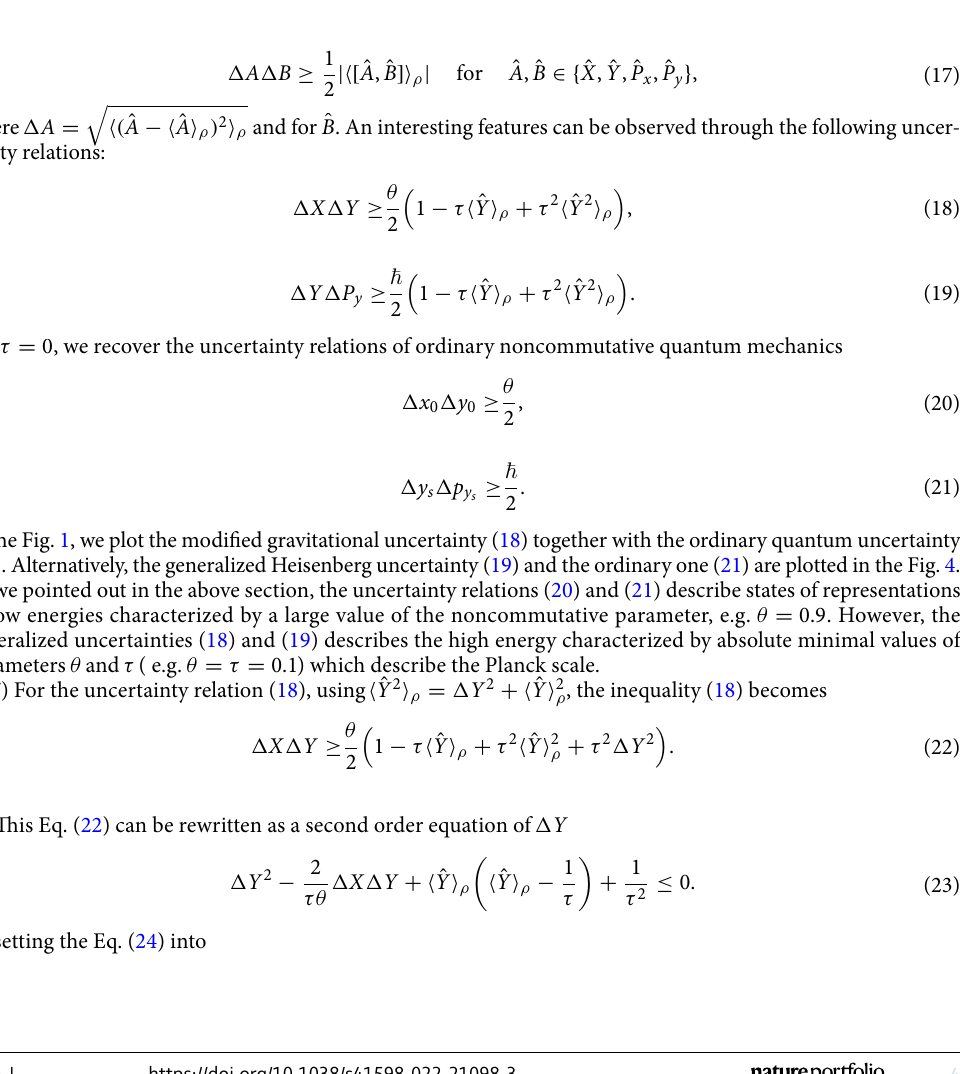
Figure 1. The quantum uncertainty relation (20) and the quantum gravitational modification (22). The quantum uncertainty (orange curve) is plotted together with a modified gravitaional uncertainty relation (blue curve) respectively. The bue shaded region represents states that are allowed by quantum gravity but forbidden by regular quantum mechanics. The brown shade region represents states allowed by both quantum gravity and quantum